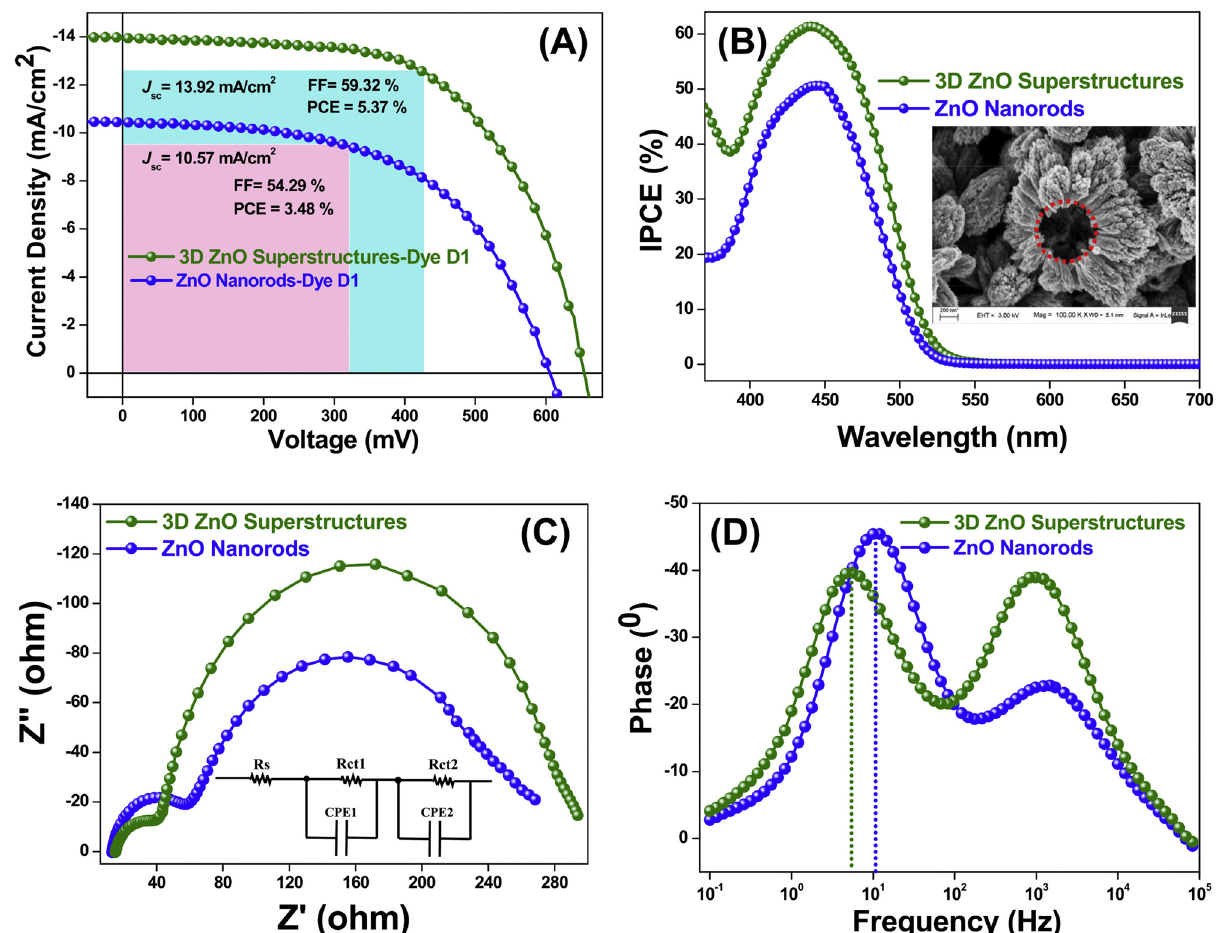
Figure 47: ( a ) J – V for ZnO heterostructure - based photovoltaic devices and corresponding ( b ) IPCE, ( c ) Nyquist, and ( d ) Bode phase plots. Copied with permission from ref. [ 475 ] ; Elsevier,